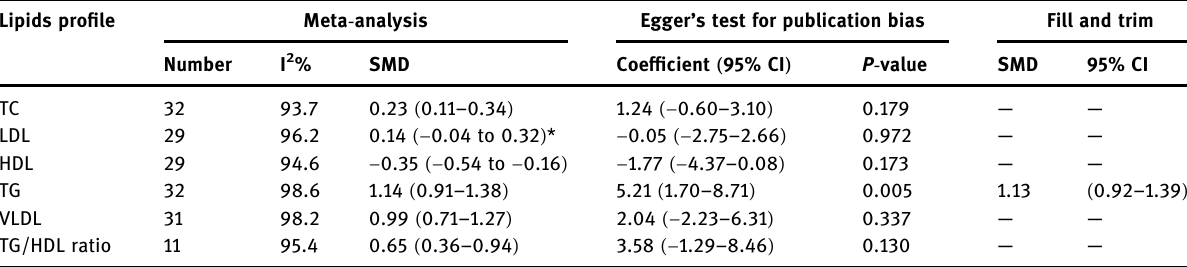
Table 3: Result of meta - analysis for calculation of lipid pro fi le SMD; publication bias and fi ll and trim method Lipids pro fi le Meta - analysis Egger ’ s test for publication bias Fill and